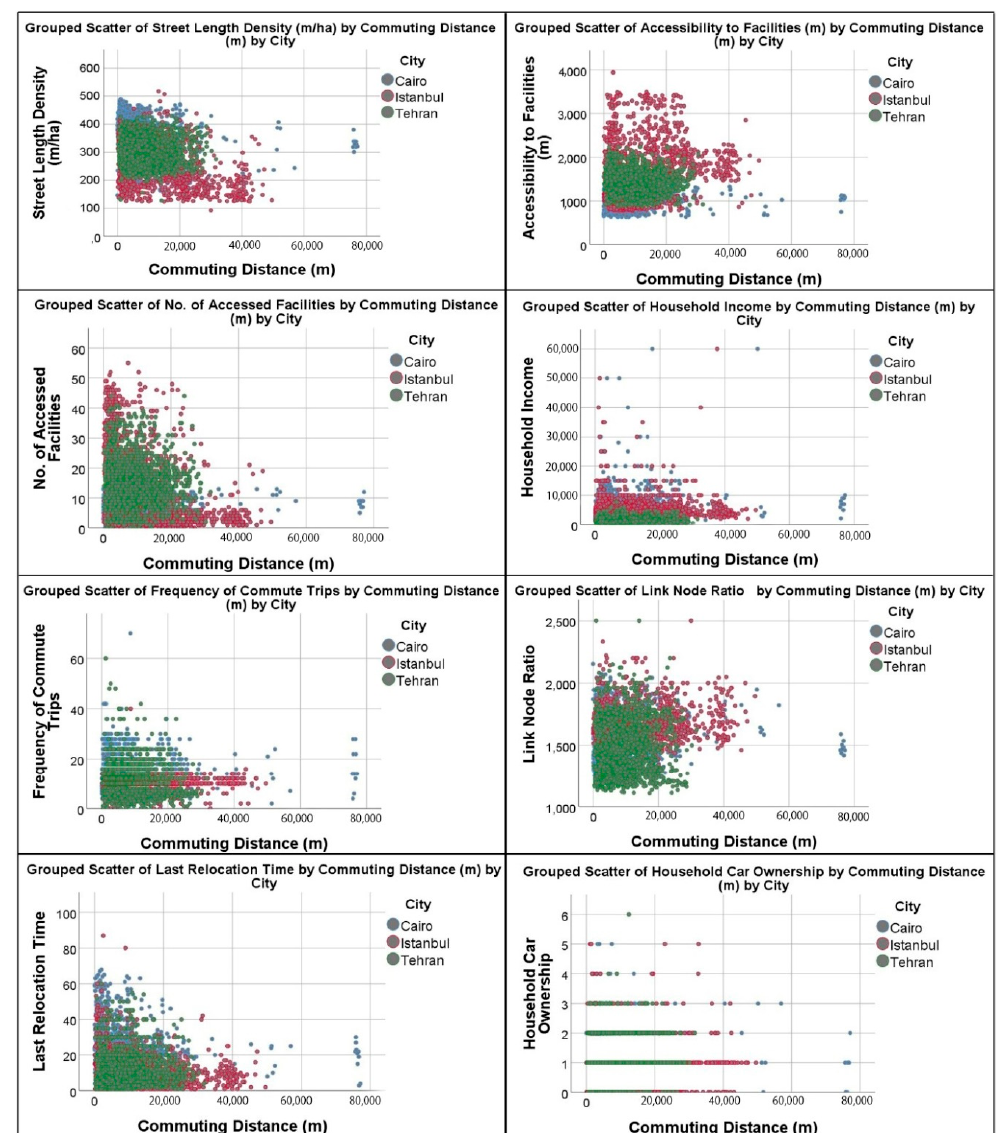
Figure 3. Scatterplots of the continuous variables of the WLS model of the MENA region distributed according to commute travel distance, grouped by city.